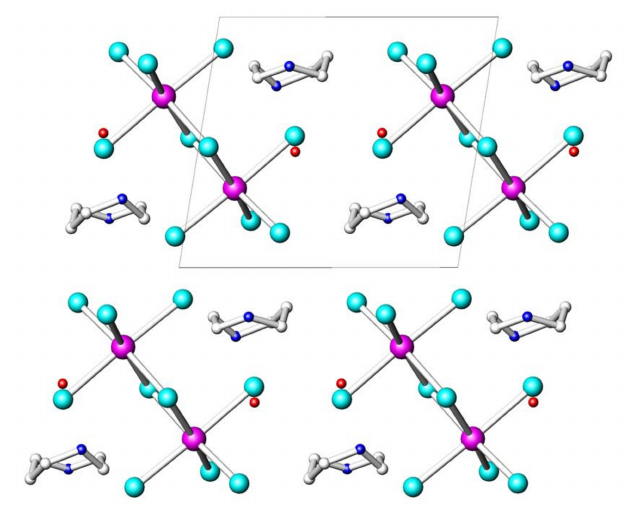
Figure 1. Projection of the crystal structure of (HpipeH 2 ) 2 Bi 2 I 10 · 2H 2 O onto (100) plane. Bismuth, magenta; iodine, cyan; oxygen, red; nitrogen, blue; carbon, light gray. Hydrogen atoms are omitted for clarity. Unit cell is shown by thin black lines.